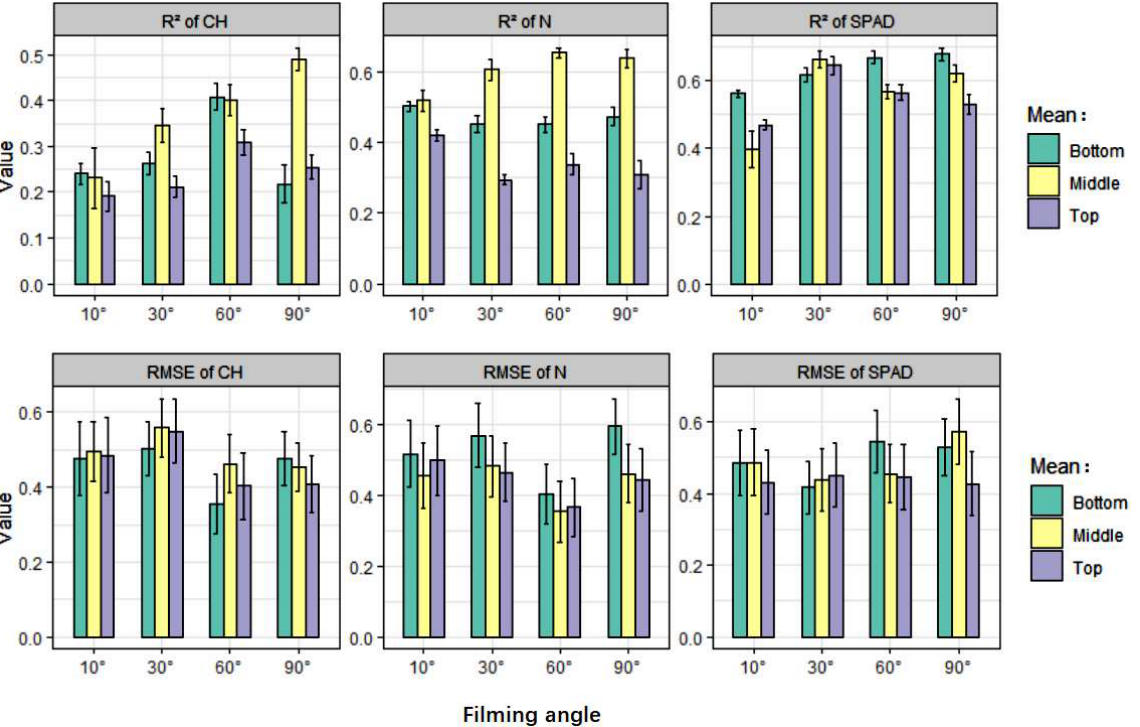
Figure 12. Comparison of the accuracy of detecting the physiological parameters for tea leaves at different positions and angles. SPAD represents the value measured with the spad-502 plus instrument, CH represents the total chlorophyll content, N represents the total nitrogen content, RMSE represents the root mean square error, and R 2 represents the coefficient of determination.